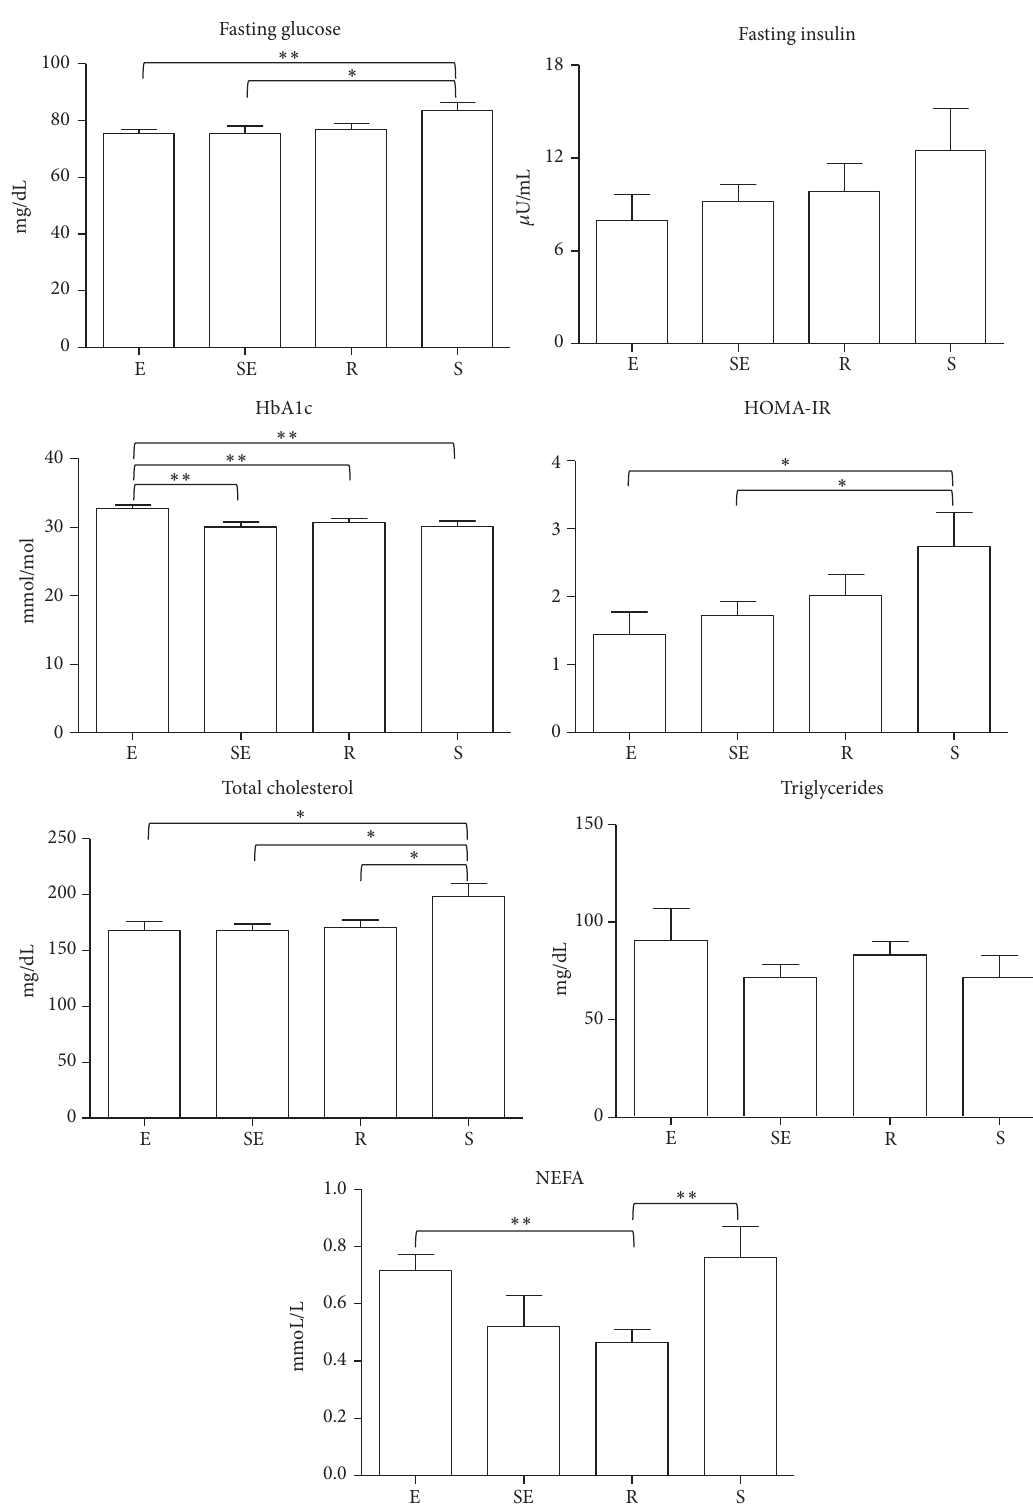
Figure 1: Fasting glucose, insulin, glycated hemoglobin (HbA1c), total cholesterol, triglycerides, free fatty acids (NEFA) levels, and HomeOstasis Model Assessment for estimating insulin resistance (HOMA-IR) values in differently trained subjects. Fasting glucose, insulin, HbA1c, total cholesterol, triglycerides, NEFA levels, and HOMA-IR values were evaluated in elite (E), subelite (SE), recreational (R), and sedentary (S) subjects. ∗ 𝑝 < 0.05 ; ∗∗ 𝑝 < 0.01